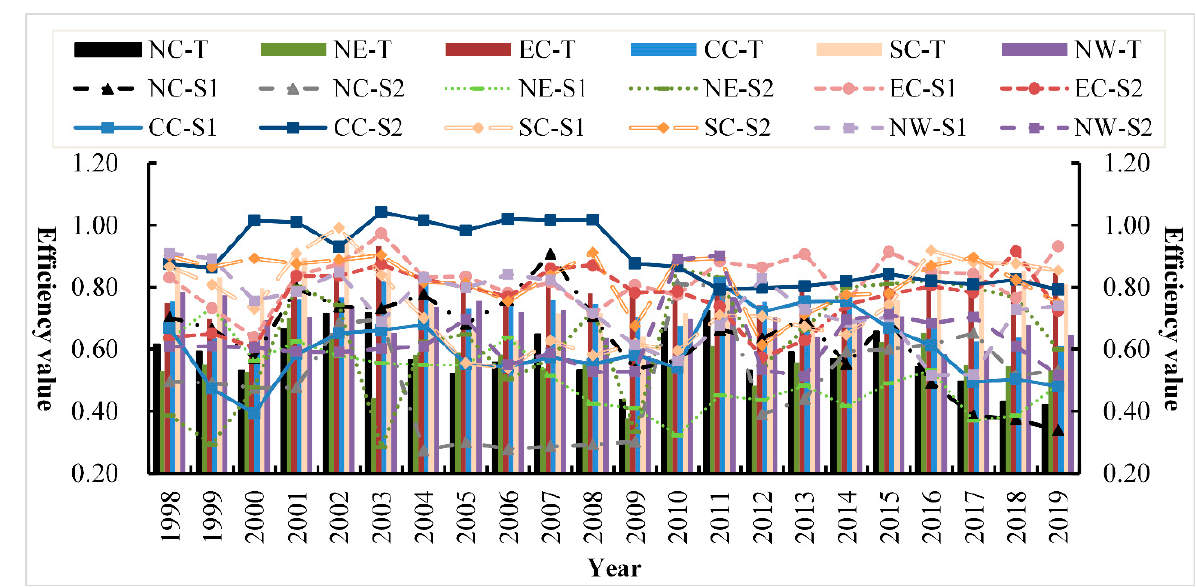
Figure 6. Comparative trend chart of regional differences in environmental efficiency in China’s power industry. Note: NC, north China; NE, northeast; EC, eastern China; CC, central China; SC, south China; NW, northwest.